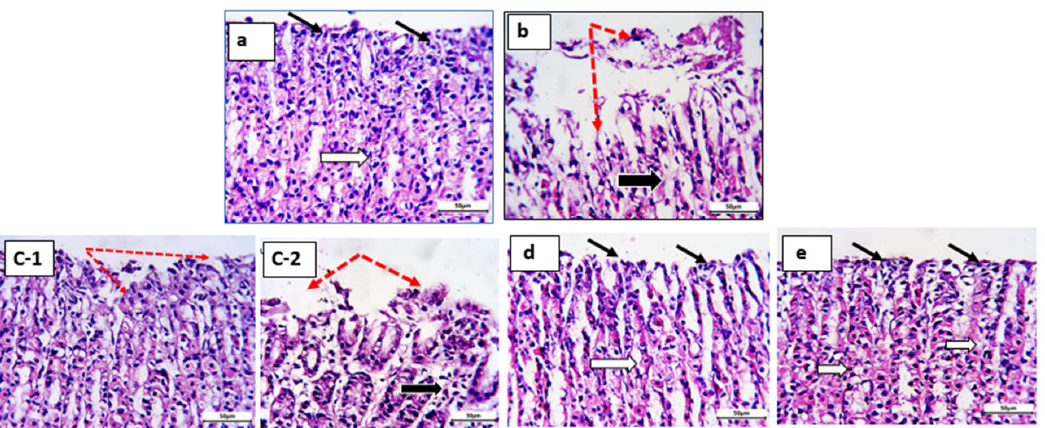
Figure 10. Histological sections from rat stomachs: ( a ) control, ( b ) ketoprofen ‐ treated group, ( C ‐ 1 , C ‐ 2 ) ketoprofen:tris Coppt, ( d ) ketoprofen:L ‐ lysine Coppt, and ( e ) ketoprofen:arginine Coppt stained by H&E and photographed at high power x 400 (bar = 50 μ m).